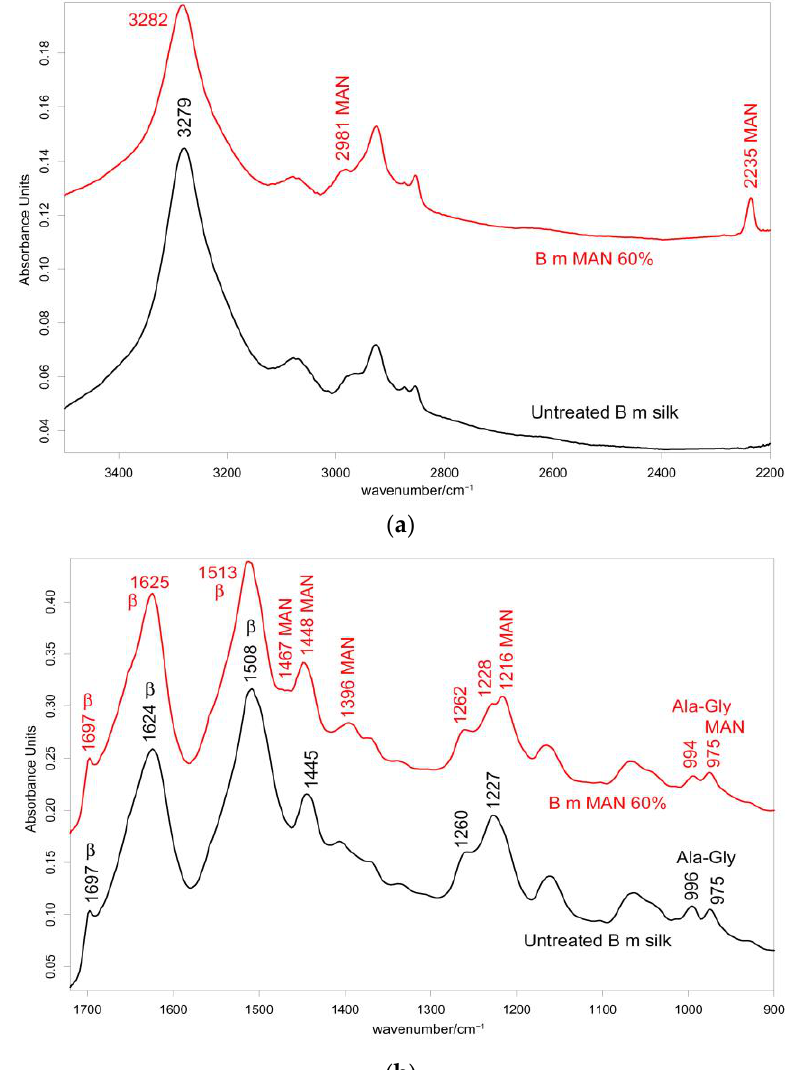
Figure 3. IR recorded in the perpendicular orientation on B. mori silk fibroin fibers before and after grafting with MAN at the highest weight gain (i.e., 60%) in the 3500–2200 cm − 1 ( a ) and 1720–900 cm − 1 ( b ) spectral ranges. The spectra are normalized to the intensity of the Amide I band (1624–1625 cm − 1 ). The main bands assigned to β -sheet ( β ) conformation, as well as to alanine-glycine domains (Ala-Gly), are indicated together with those having a contribution from MAN.